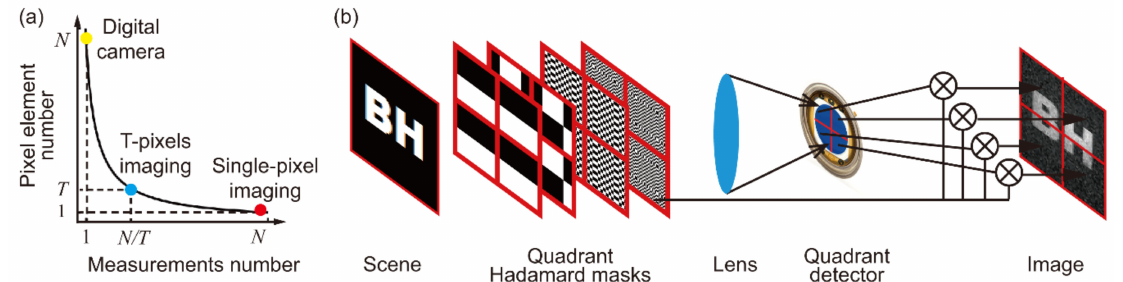
Figure 3. Space–time trade-off relationship for performing N measurements: ( a ) Single-pixel imaging and digital cameras are at the two ends of the curve, while the idea of using T pixels and N / T measurements is a compromise between the two extremes; ( b ) by using a quadrant detector, the imaging system is 4 times faster in data acquisition [79].